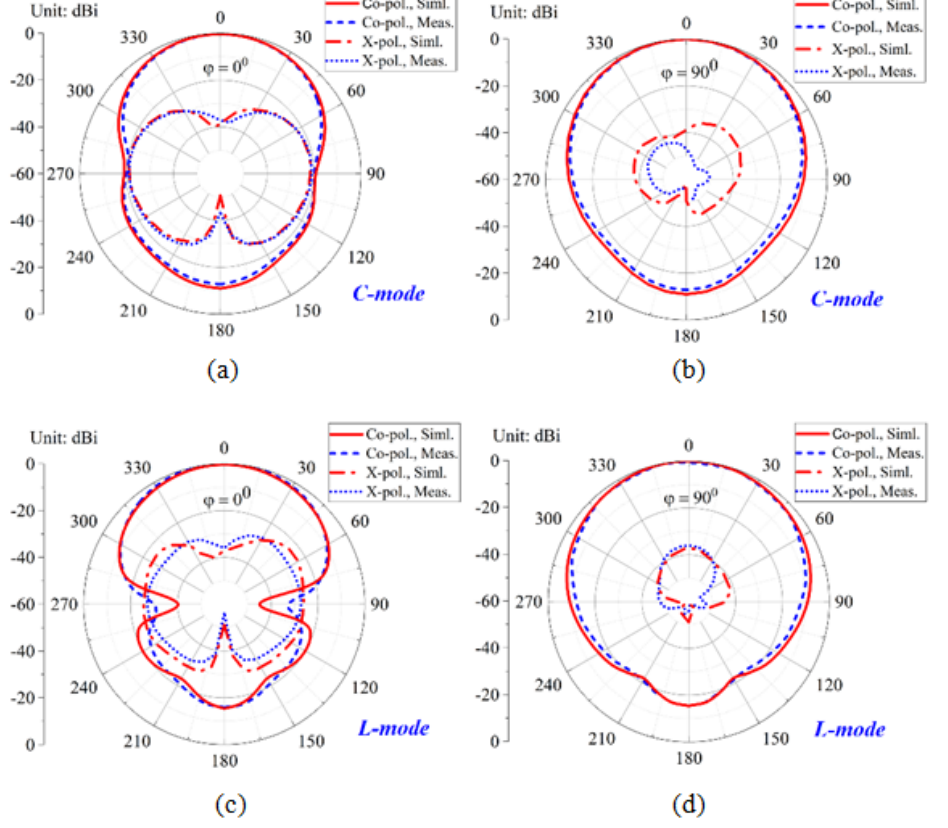
Figure 17. Simulated and measured radiation plots of the proposed antenna configuration at ( a ) 2.45 GHz ( φ = 0 ◦ ), ( b ) 2.45 GHz ( φ = 90 ◦ ), ( c ) 4.0 GHz ( φ = 0 ◦ ), and ( d ) 4.0 GHz ( φ = 90 ◦